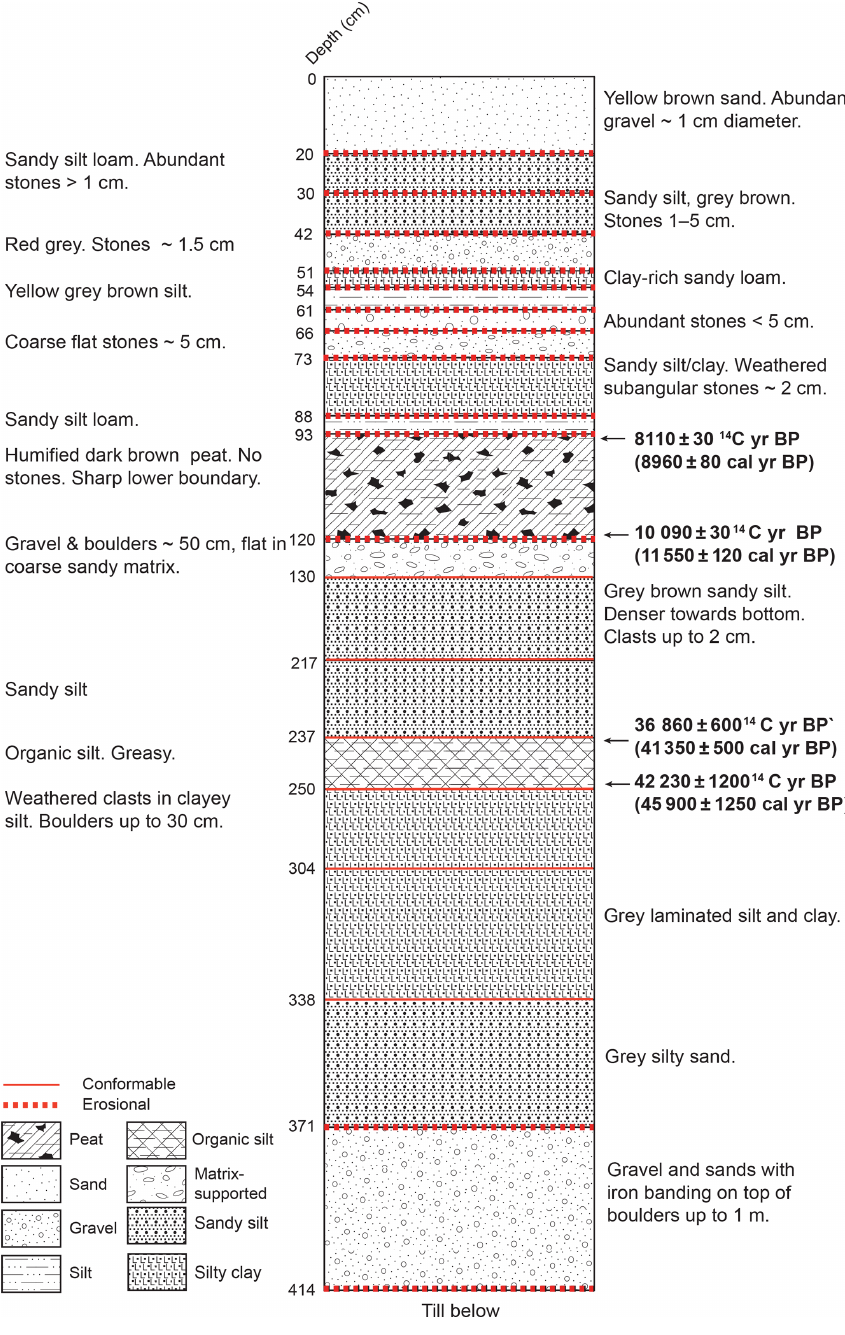
Figure 3. Schematic of exposed sediment section surveyed and sampled at Pillar Rock, Auckland Island. Radiocarbon dates of organic sections given as uncalibrated 14 C dates and calibrated mean ages. Not to